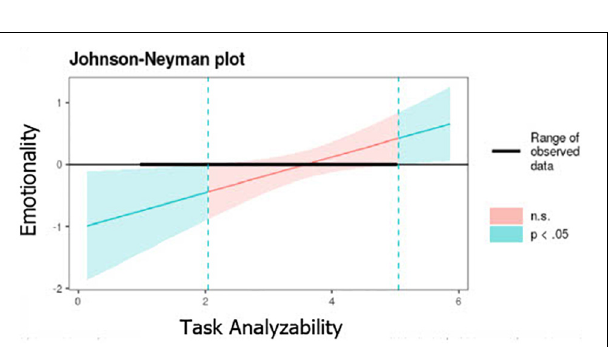
FIGURE 4 | The moderating effect of TA on the relationship between emotionality and LMX.